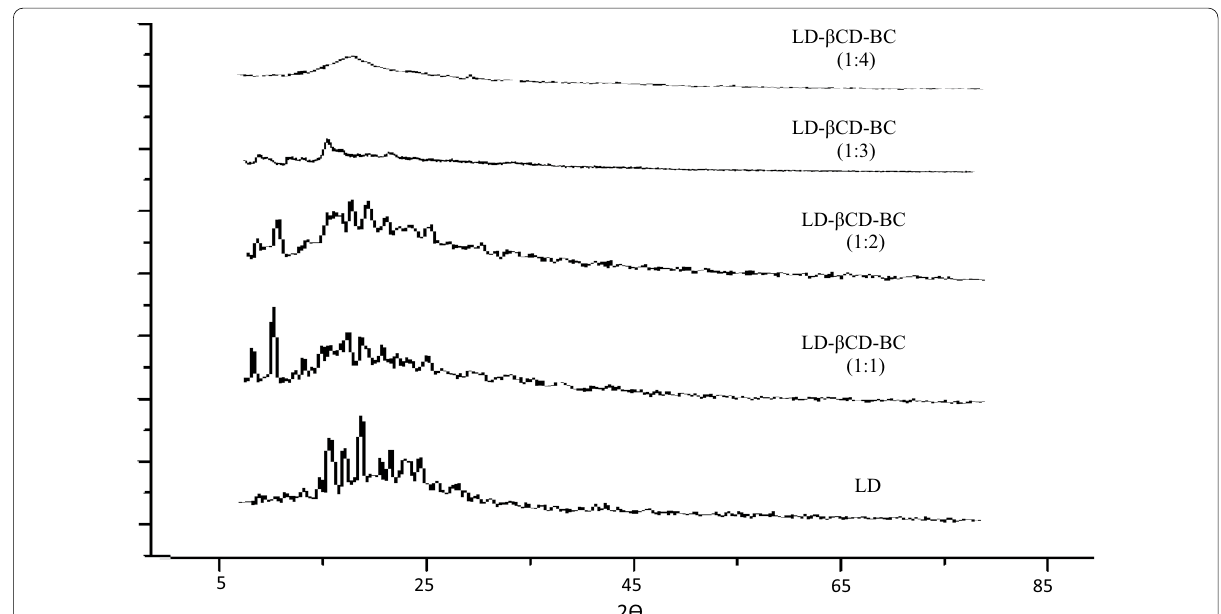
Fig. 10 The X-ray diffractograms of LD, and its prepared freeze-dried, binary complexes of different ratios, LD-βCD-BC (1:1), LD-βCD-BC (1:2),